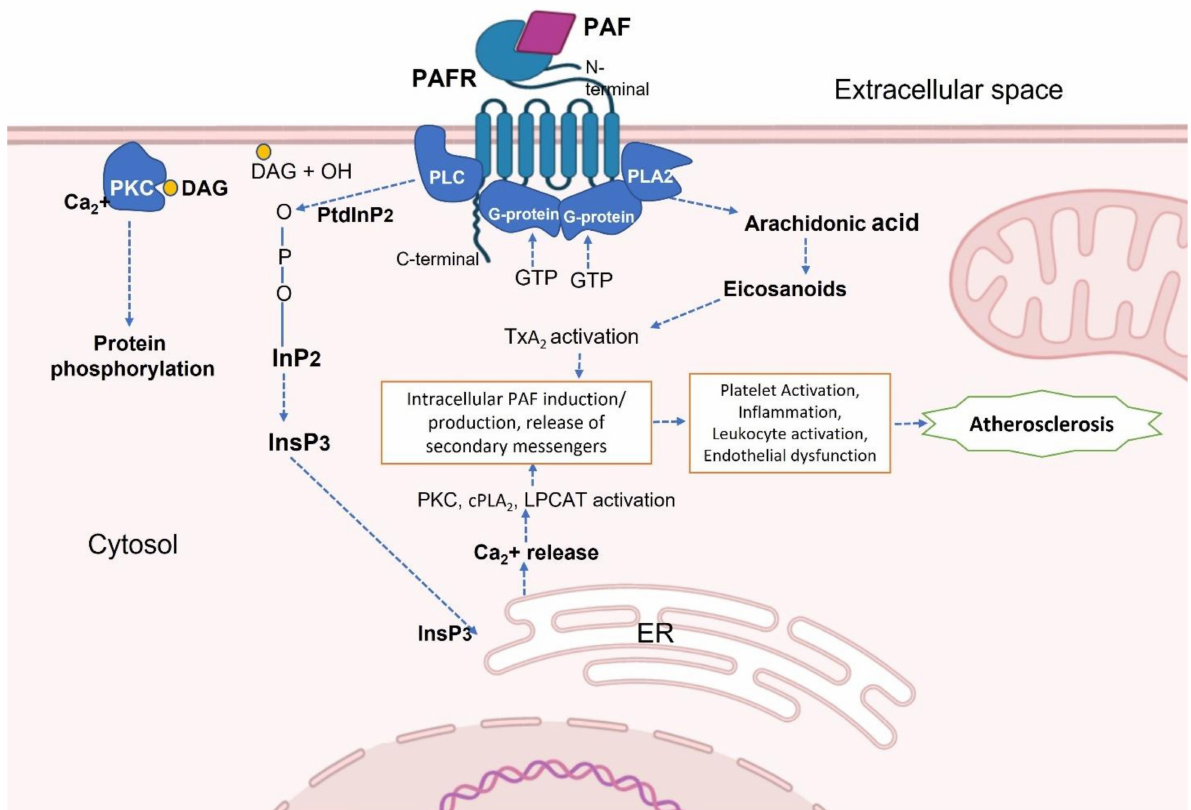
Figure 3. Mechanism of PAF-R activation and PAF-mediated signalling pathway [59,60]. Abbrevia- tions: cPLA 2 —cytosolic phospholipase A 2 ; DAG—Diacylglycerol; ER—Endoplasmic reticulum; InP 2 —inositol 4,5-bisphosphate; InsP 3 —inositol 1,4,5-triphosphate; LPCAT—lysophosphatidylcholine acyltransferase; PKC—protein kinase C; PLA 2 —Phospholipase A 2 ; PLC—Phospholipase C; PtdInP 2 — phosphatidyl 4,5-bisphosphate; TxA 2 —thromboxane A 2